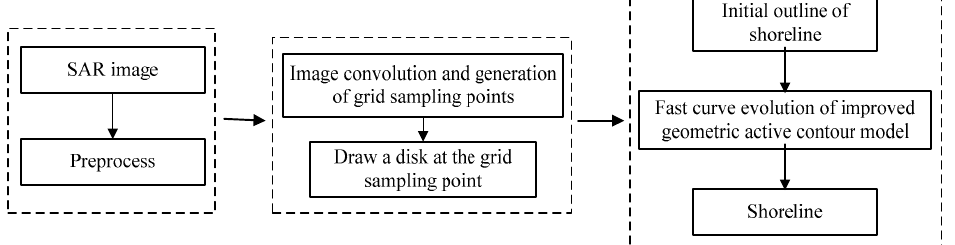
Figure 4. Extraction process of shoreline.